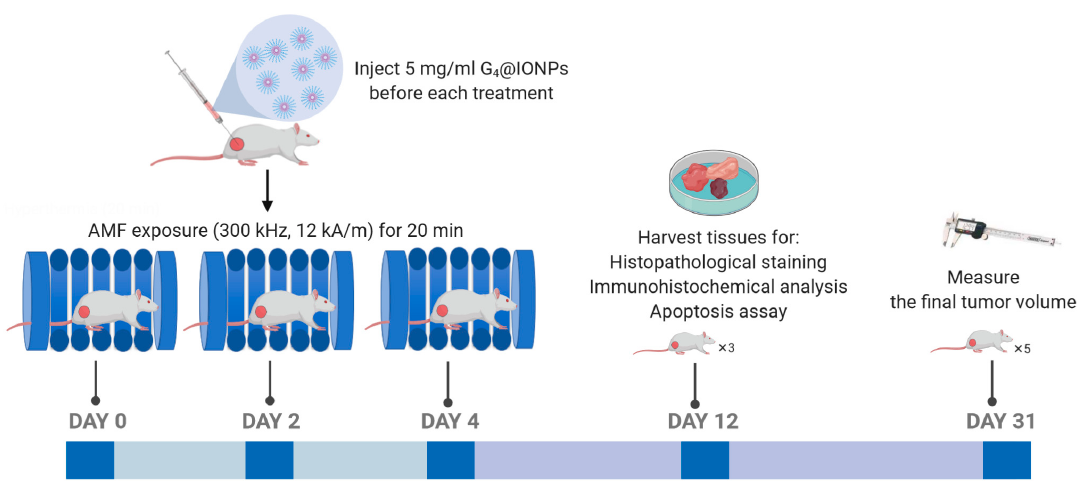
Figure 1. Experimental workflow for magnetic hyperthermia treatment in breast cancer-bearing BALB / c